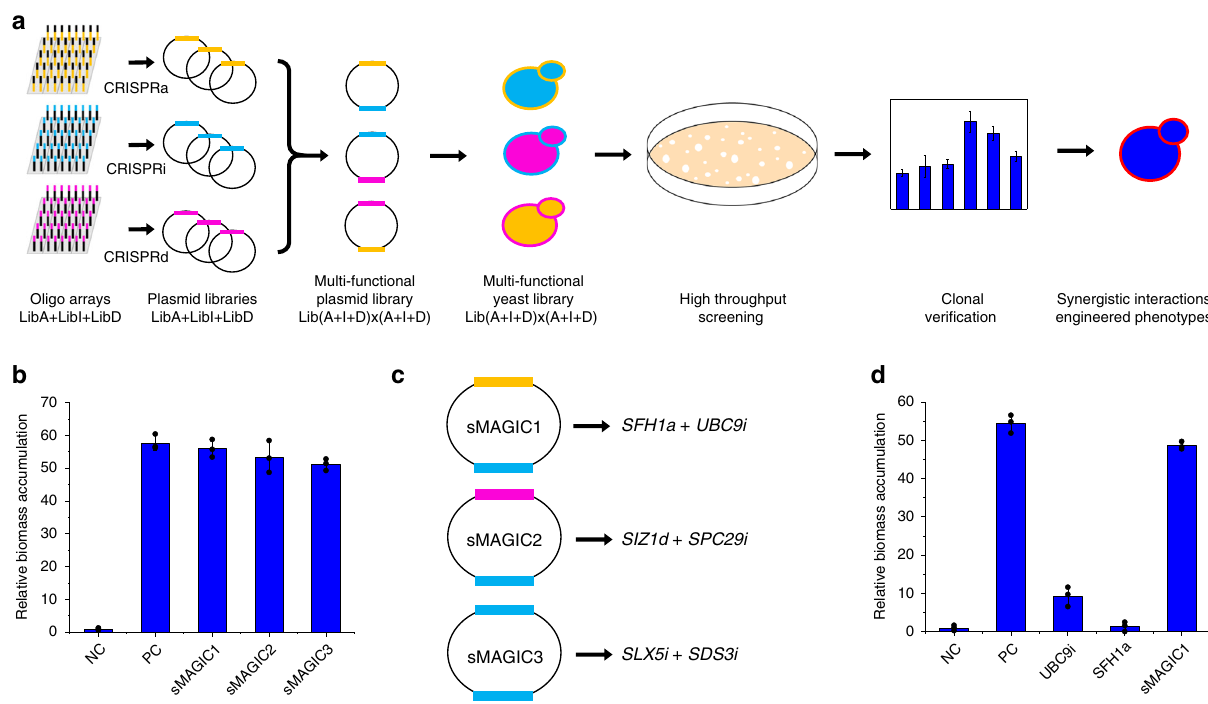
Fig. 5 Engineering of furfural tolerance with sMAGIC. a The sMAGIC pipeline for furfural tolerance engineering. The sMAGIC plasmid library was constructed by assembling two genome-scale CRISPR-AID (LibA + LibI + LibD) into the same vector [Lib(A + I + D)×(A + I + D)] using Golden-Gate Assembly. The sMAGIC yeast library was constructed by transforming the sMAGIC plasmid library into the bAID strain and subject to colony-size-based high throughput screening on agar plates. b Furfural tolerance of the engineered strains identi fi ed by sMAGIC screening. The strains containing an empty vector (NC) and SIZ1i - NAT1a (PC) were included as a negative control and a positive control, respectively. c Sequencing results of top clones identi fi ed by sMAGIC screening, including sMAGIC1 ( UBC9i - SFH1a ), sMAGIC2 ( SIZ1d - SPE29i ), and sMAGIC3 ( SLX5i - SDS3i ). d Single ( UBC9i or SFH1a ) and double ( UBC9i - SFH1a ) mutants were constructed to investigate the synergistic interactions between SFH1a and UBC9i for enhanced tolerance against furfural (10 mM). Error bars represent the mean ± s.d. of biological triplicates. The source data for fi gures b and d are provided as a Source Data fi